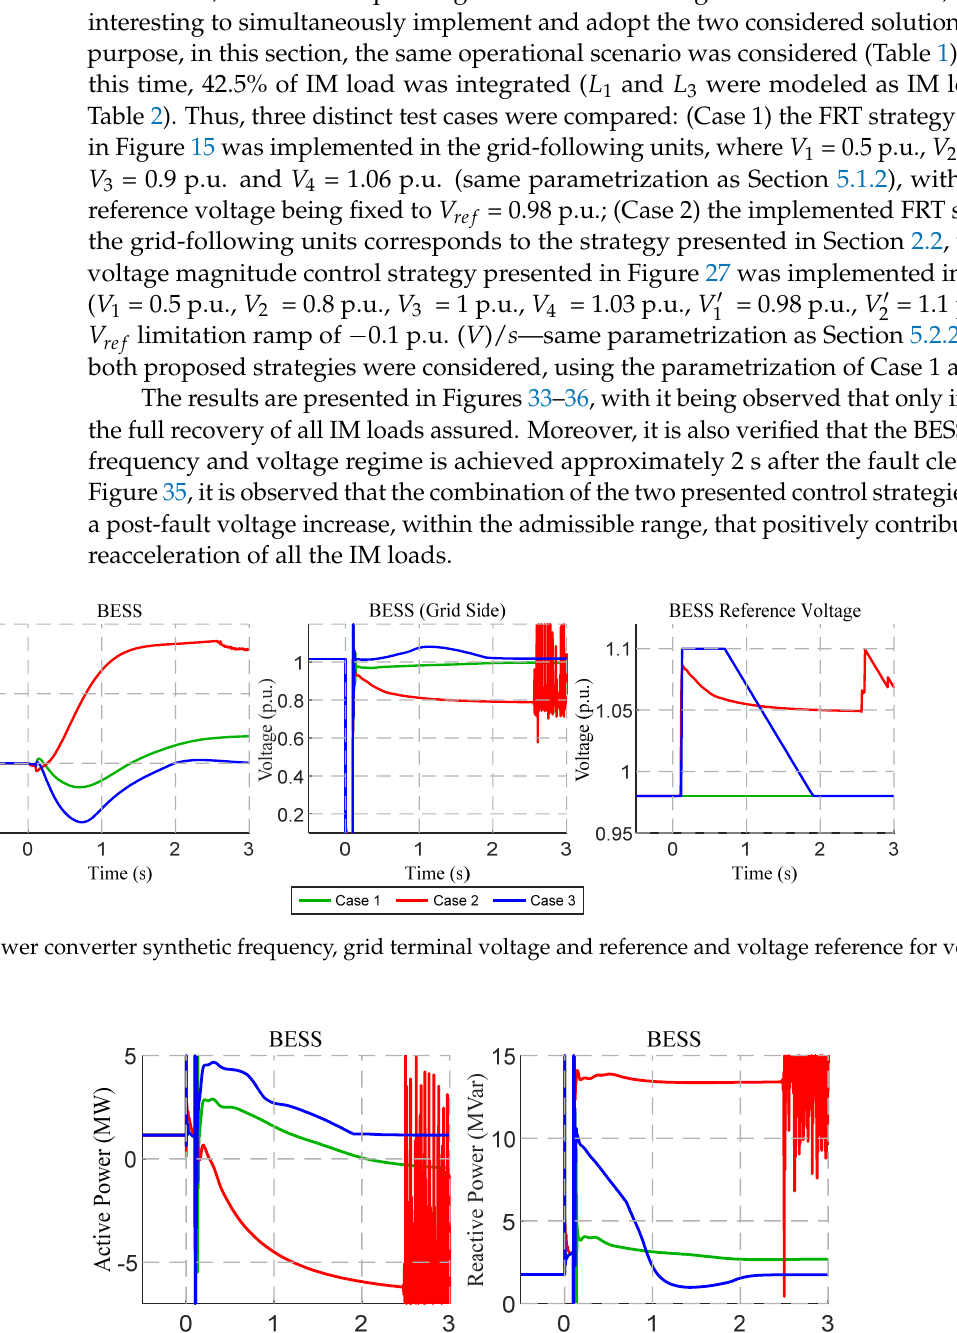
Figure 35. WF1 reactive current output and terminal voltage. 0